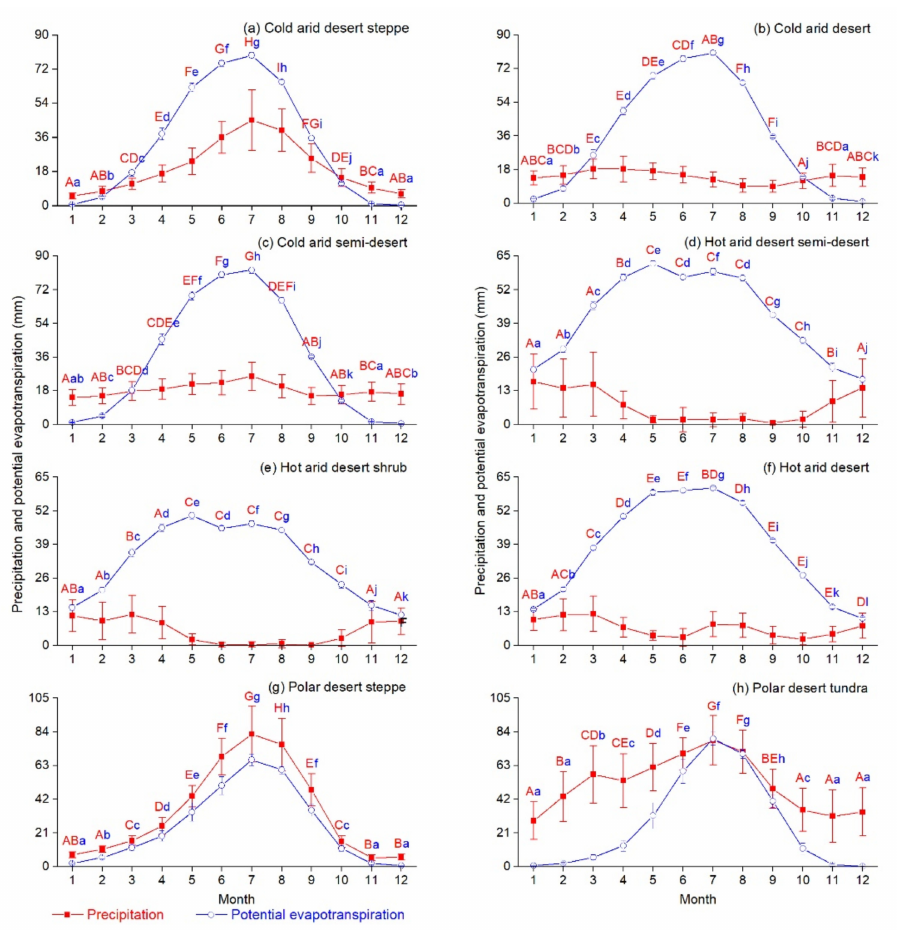
Figure 5. Variation of mean monthly precipitation and potential evapotranspiration in different desert areas over the Silk Road Economic Belt between 1982 and 2015. Different red uppercase letters indicate significant differences in precipitation between different months at p < 0.05, and different blue lowercase letters indicate significant differences in potential evapotranspiration between different months at p < 0.05. ( a – h ) indicate different desert areas,